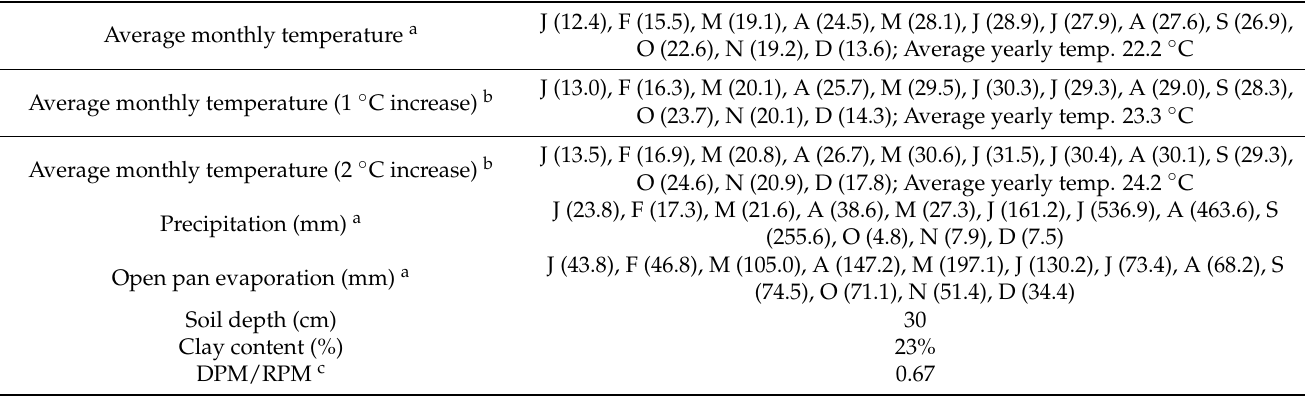
Table 1. Data requirement for